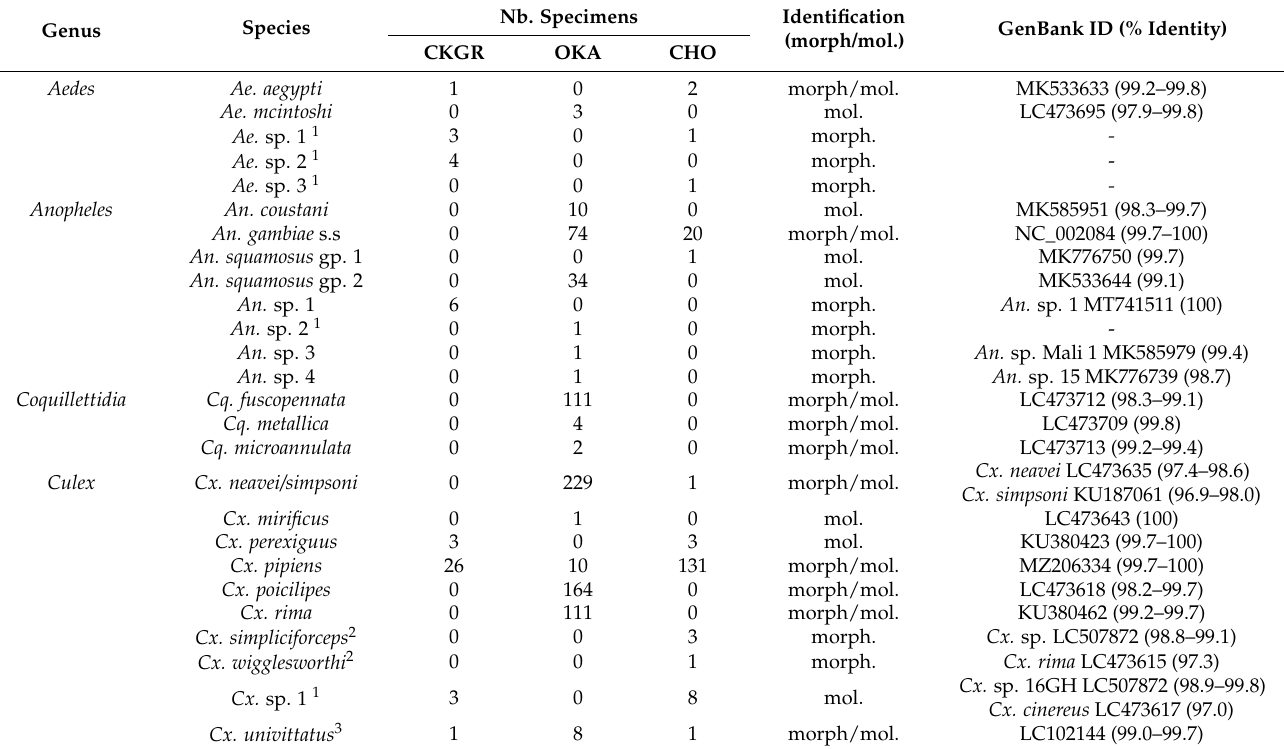
Table 3. Mosquito identification information of species collected from major tourism destinations (Central Kalahari Game Reserve (CKGR), Okavango (OKA) and Chobe enclave (CHO)) in Botswana. Specimens were identified morphologically (morph.), molecularly (mol.) or both (morph/mol.) as described in the Materials and Methods section. The GenBank reference is given with pairwise identities (%). The GenBank corresponding reference, if available, is given whenever morphological identity is undefined at the species